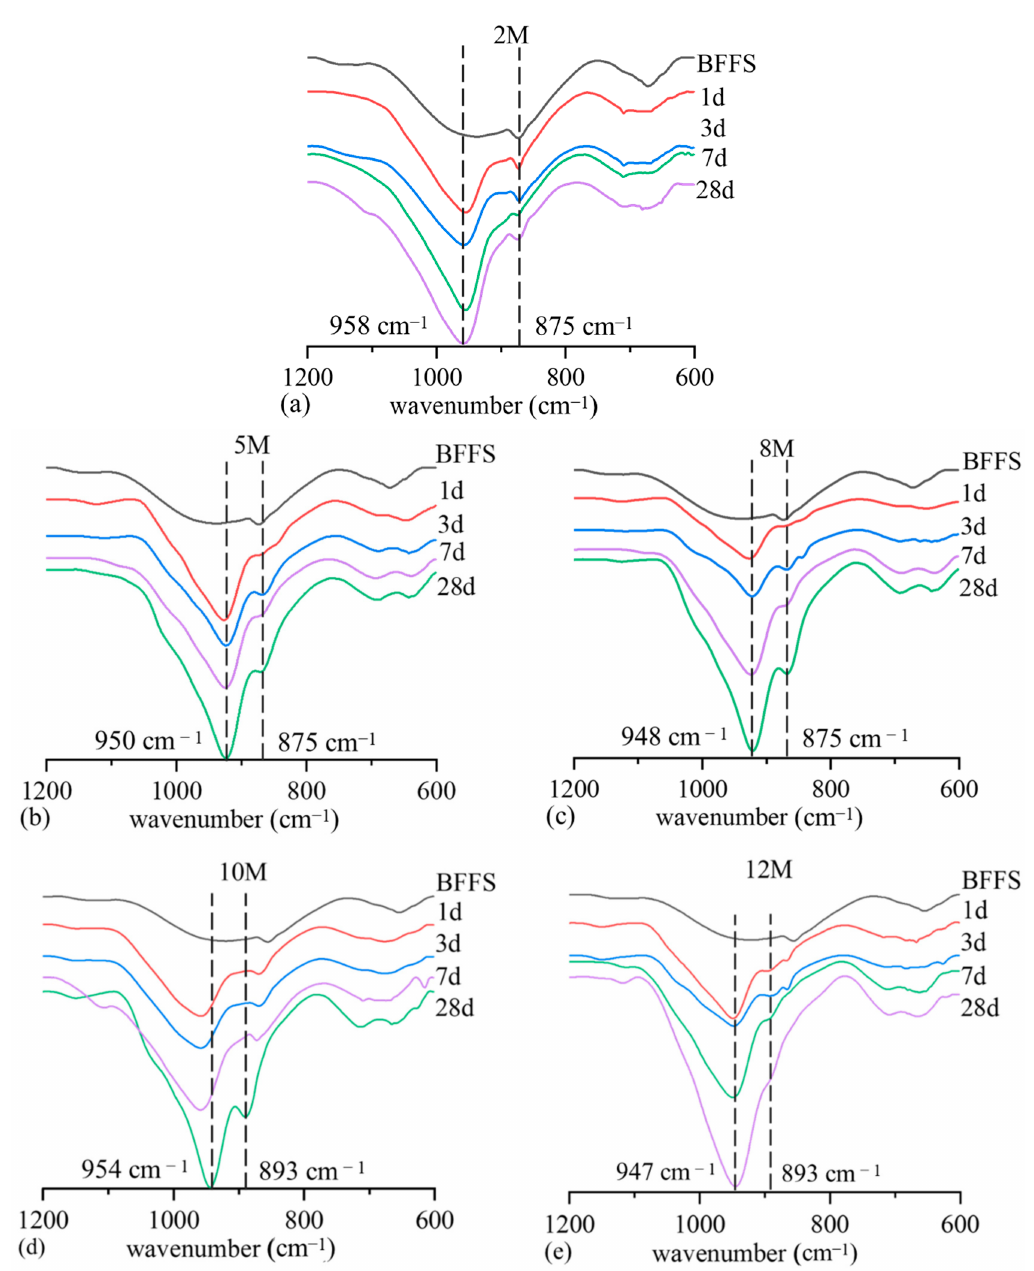
Figure 6. FT-IR spectra of hardened pastes at different ages: ( a ) 2 M, ( b ) 5 M, ( c ) 8 M, ( d ) 10 M and ( e ) 12